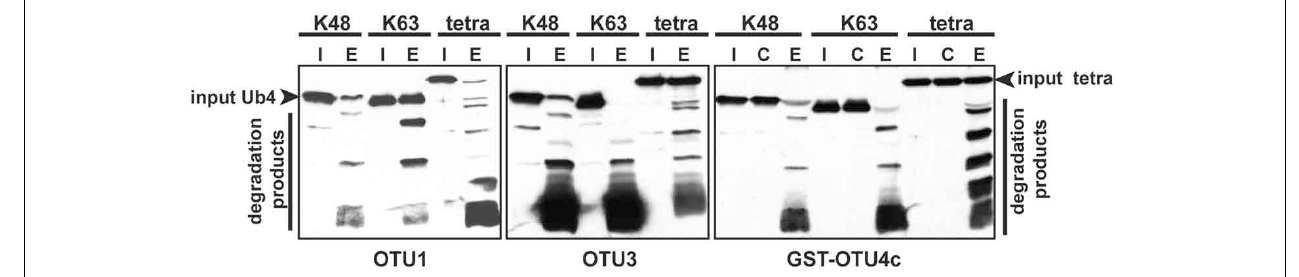
FIGURE 3 | The relative cleavage activities of A. thaliana OTU1, OTU3, and OTU4c against linear (tetra) and K48- or K63-linked UB tetramers. The cleavage activities were analyzed using His-tagged OTU1 and OTU3 and His/GST-tagged OTU4c (E). GST was included as a negative control for